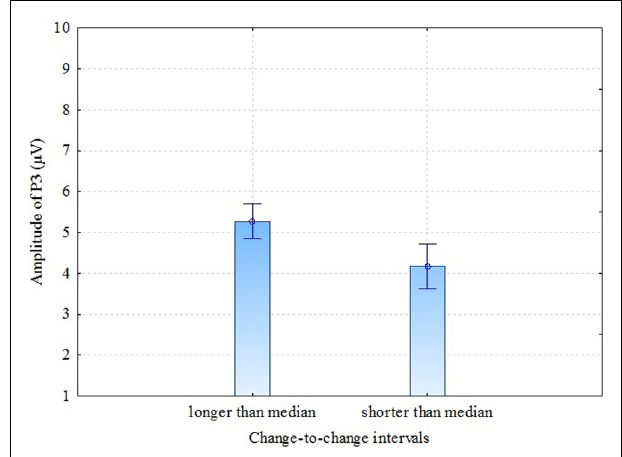
FIGURE 5 | P3 amplitudes (over F, C,T, P, and O regions) for the color change of slower and faster moving stimuli by two earliest (sp1–2) and latest switch-points (sp9–10). Vertical bars denote ± standard error.